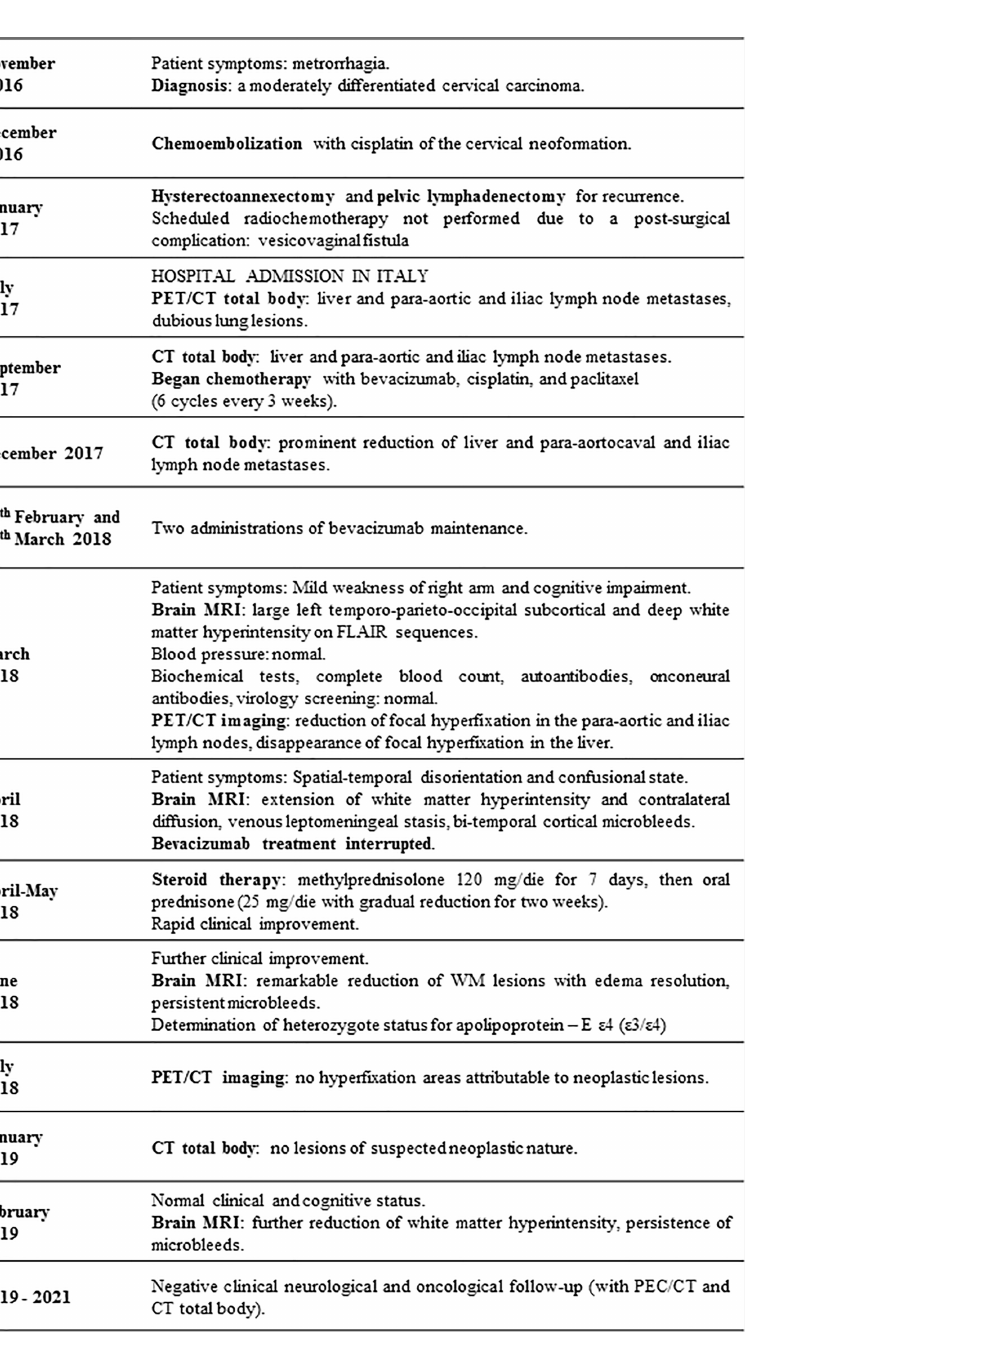
FIGURE 2 | Timeline of clinical course and